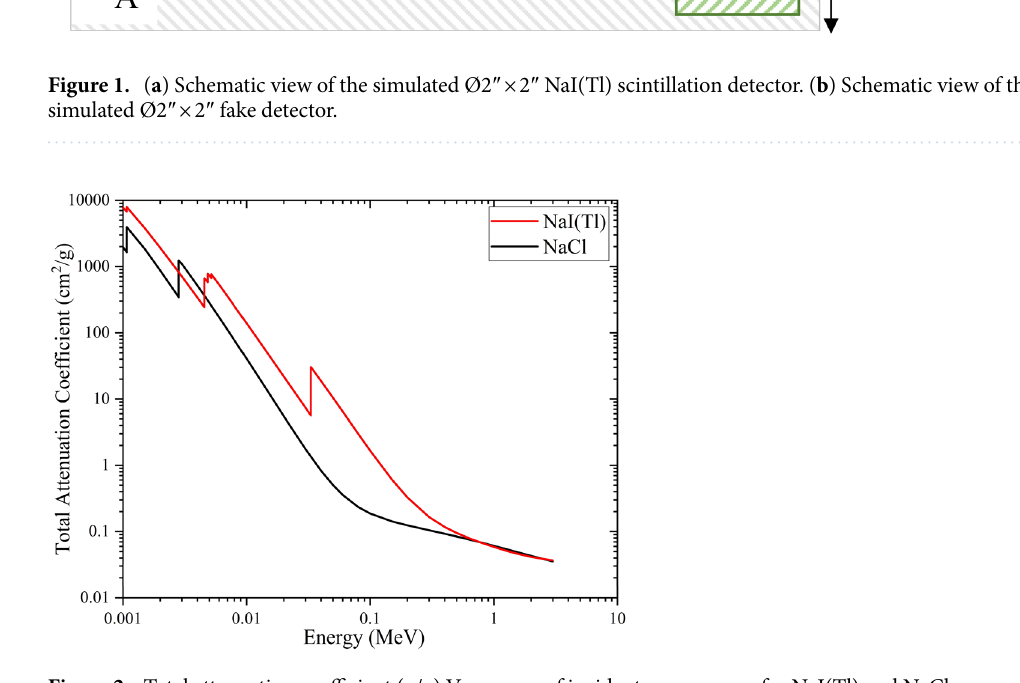
Figure 2. Total attenuation coefficient ( μ / ρ ) Vs. energy of incident gamma-rays for NaI(Tl) and